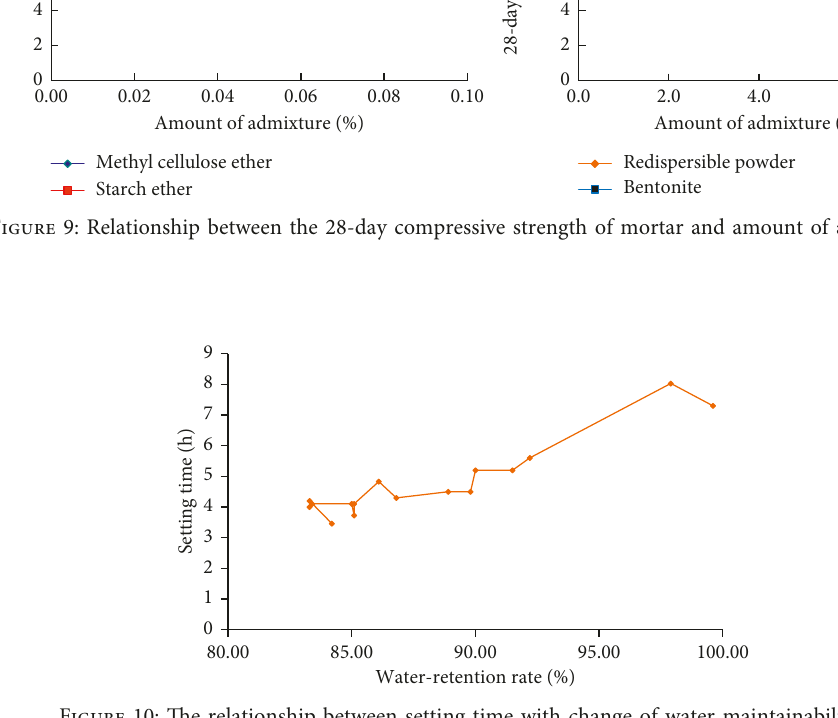
Figure 10: The relationship between setting time with change of water maintainability.